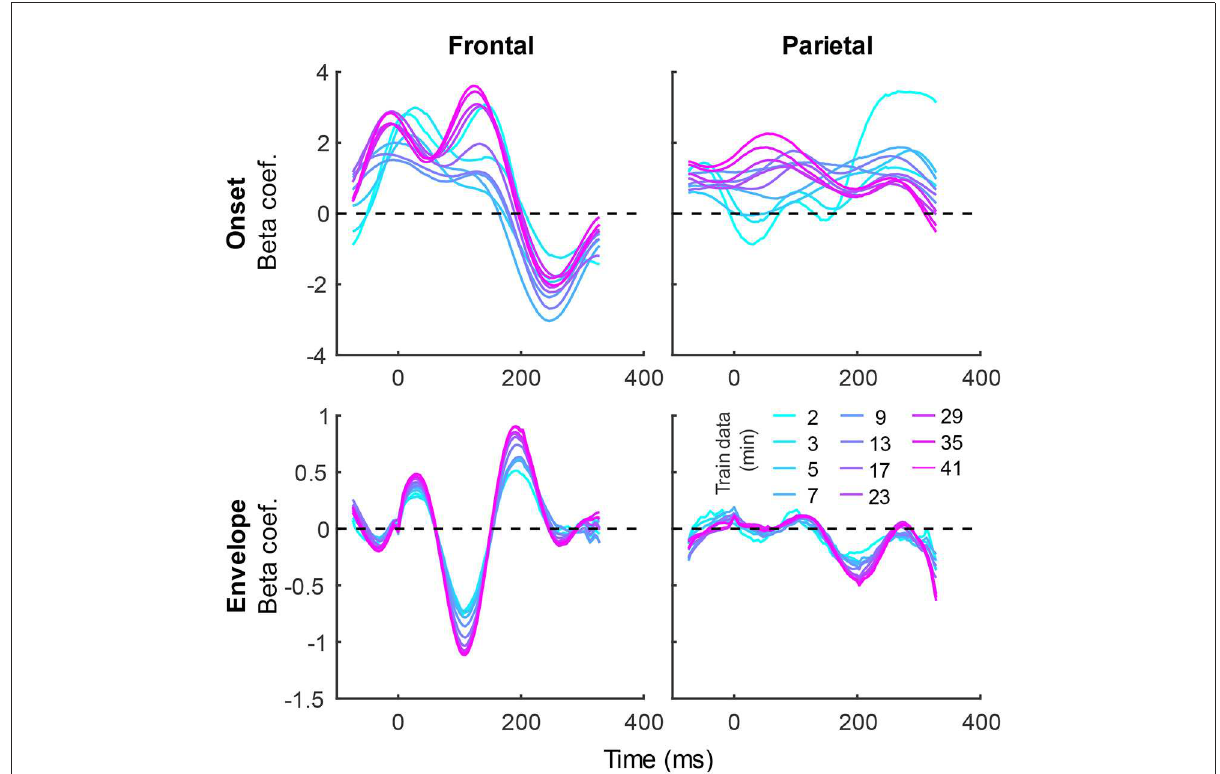
FIGURE4 Group-averaged TRF time courses of model beta coefficients for onset (top row) and envelope (bottom row) features from the denser model in frontal (left column) and parietal (right column) ROIs. TRFs estimated using different amounts of data are depicted in different colors (see legend above the lower right plot ). The small sharp deflections in envelope response around t = 0ms reflect mild leakage of electrical artifact from earphones into the EEG signal. See also heatmap depiction of the TRFs in Supplementary Figure 1 for easier comparison across different data quantities, and Supplementary Figure 3 for correlation matrices comparing TRF morphologies across different data